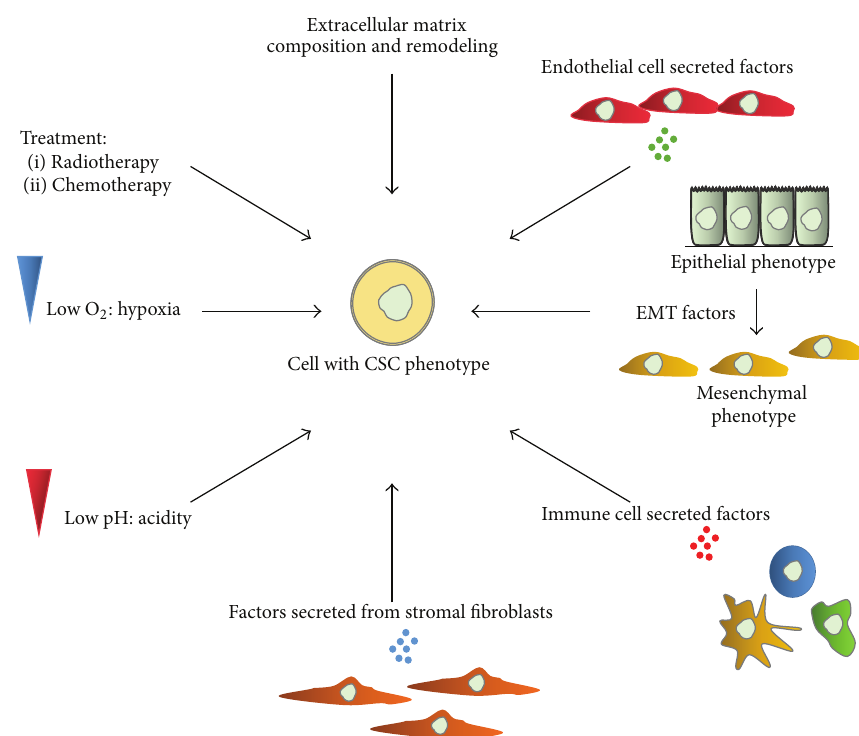
Figure 4: Mechanisms inducing CSC phenotypes. The CSC phenotype of cancer cells is influenced by cues related to the tumor microenvironment. These include remodeling of the extracellular matrix and signaling through factors secreted by endothelial, immune system cells and stromal fibroblasts. Signaling related to EMT (epithelial to mesenchymal transition) may also induce a CSC phenotype. Low oxygen (hypoxia) and acidic conditions nearby the CSC niche may induce and/or enhance the CSC phenotype of cells. Radiotherapy and chemotherapy have been shown to induce dedifferentiation of cancer cells and acquisition of a CSC phenotype. Figure was constructed in part with objects from Servier Medical Art documents under license from Creative Commons Attribution 3.0 France